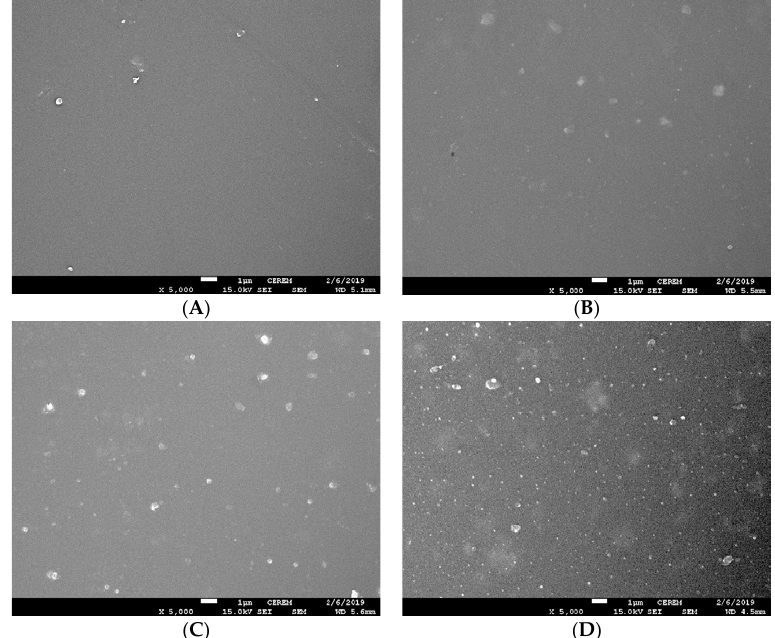
Figure 1. SEM images of ( A ) Epoxy, ( B ) SN-1, ( C ) SN-3, and ( D ) SN-5.